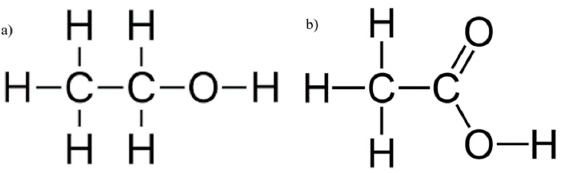
Figure 3. Chemical structures of ethanol and acetic acid,